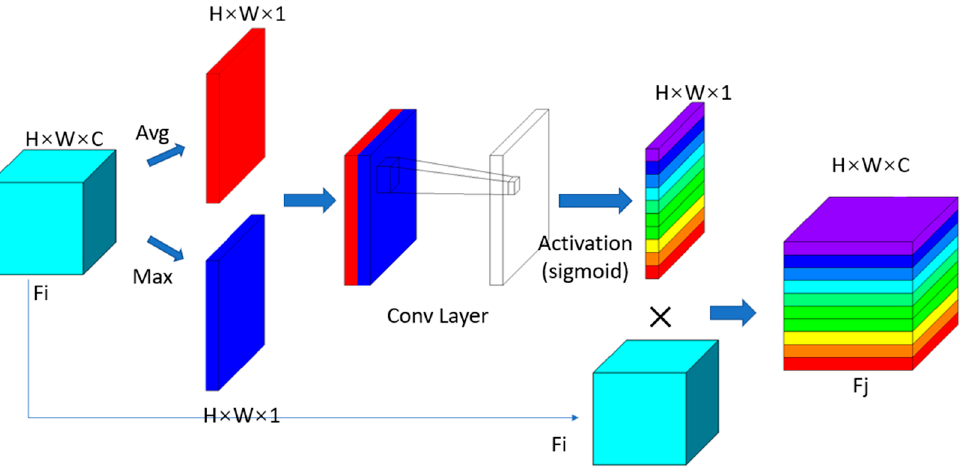
Figure 3. Structure of the spatial attention module. H, W, and C are height, width, and channel, respectively, representing the input size.